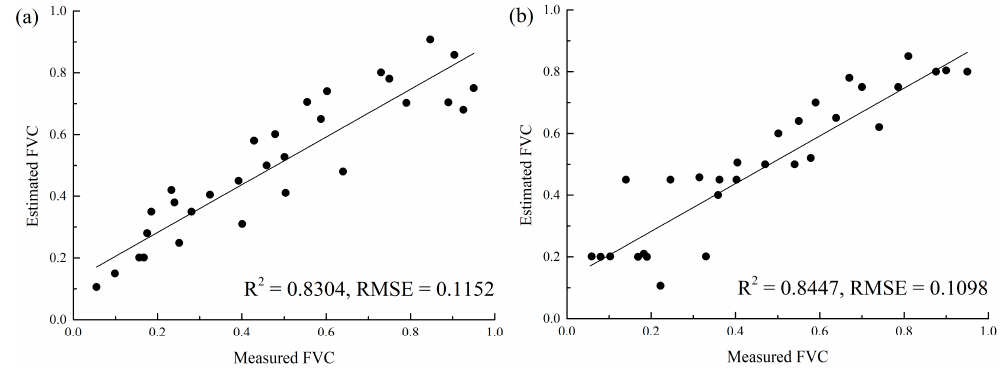
Figure 3. Result of accuracy validation of the sub-pixel model in: (a) Nandong, and (b) Xiaojiang watershed.